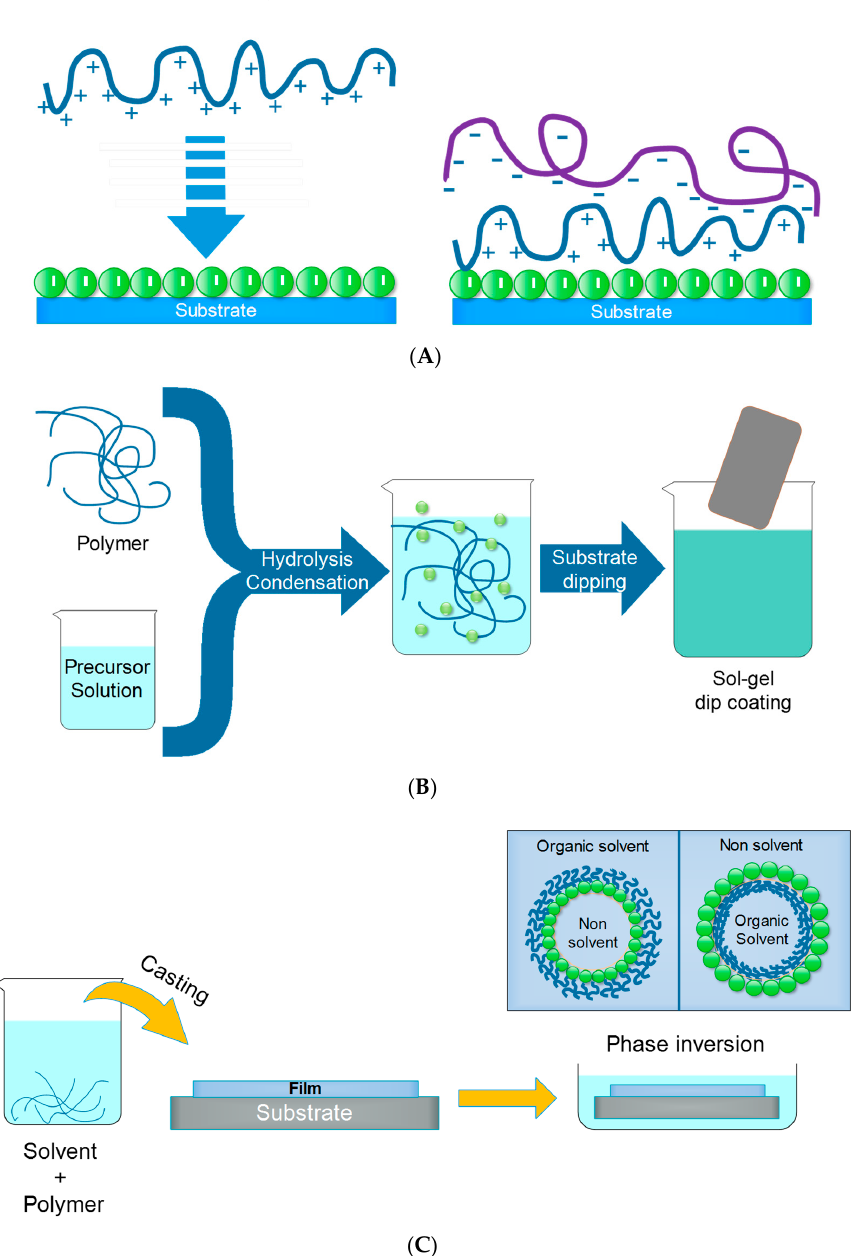
Figure 5. The most common coating methods; ( A ) layer-by-layer technique, ( B ) sol-gel, ( C ) phase inversion method. inversion